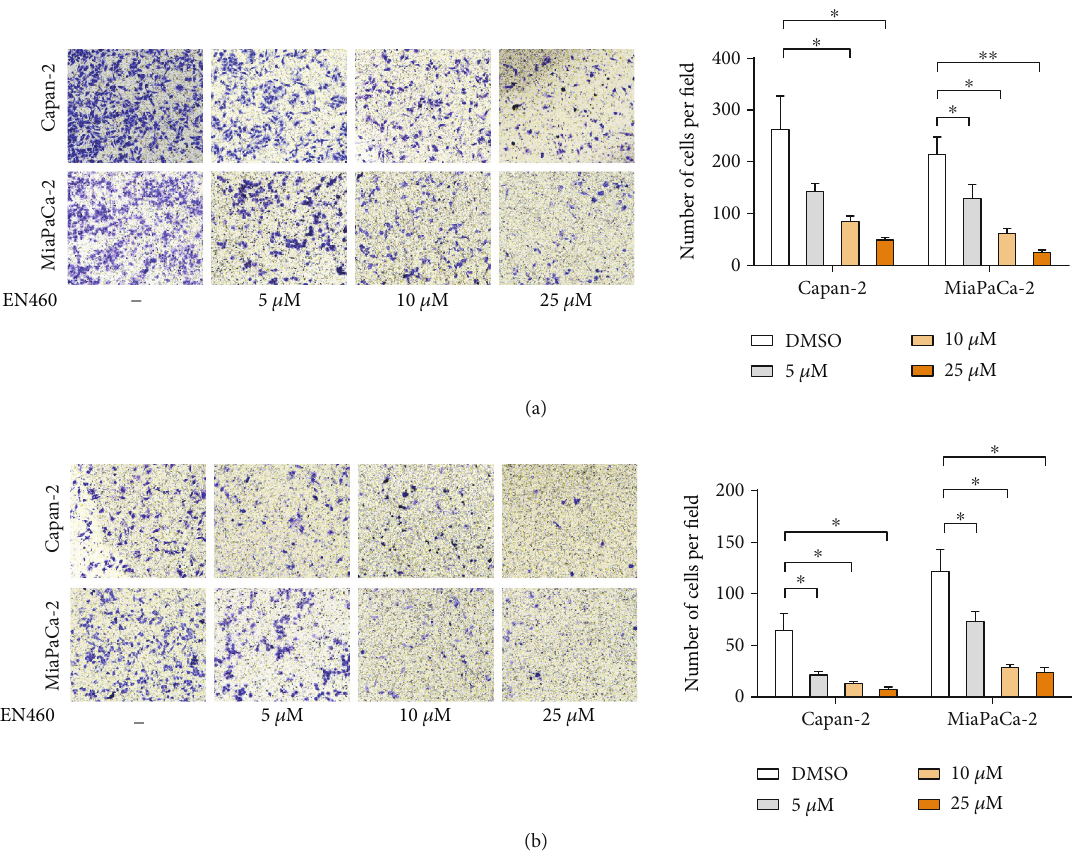
Figure 3: Pharmacological inhibition of ERO1L suppresses migration and invasion of PDAC in vitro. (a) Transwell assays with/without coated Matrigel showing the role of ERO1L inhibitor, EN460 in PDAC cell migration in vitro. (b) Transwell assays with/without coated Matrigel showing the role of ERO1L inhibitor, EN460 in PDAC cell invasion in